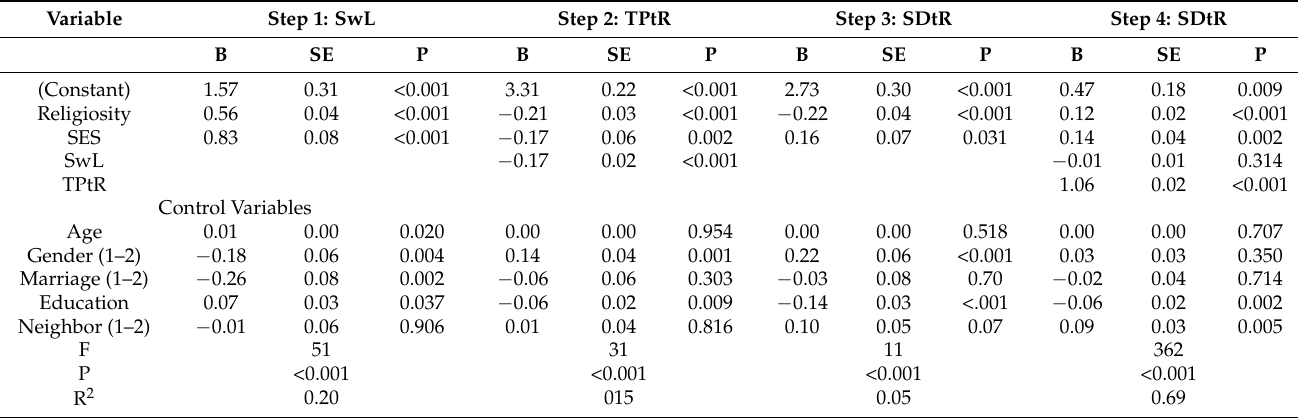
Table 4. Direct effects on SwL, TPtR, and SDtR.